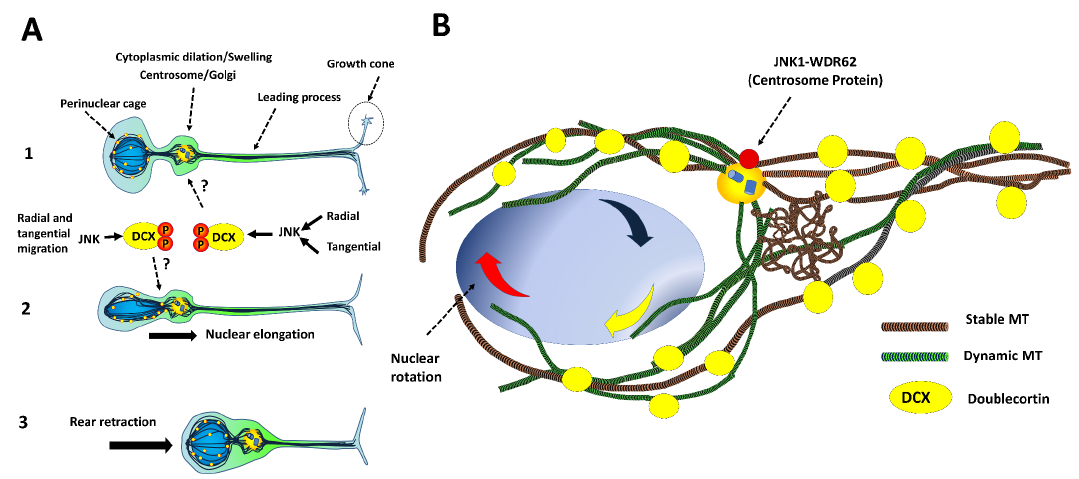
Figure 5. JNK1 regulates the phases of neuronal migration. ( A ) (1) Initially, the leading process is extended; (2) Later, the nucleus is pulled forward by the reorganization of microtubules that round the perinuclear cage; (3) Finally, rear retraction occurs. ( B ) Magnification of the perinuclear cage formed by MT. MTs (red and brown) are located around the nucleus (blue). The Centrosome / Golgi apparatus irradiates MTs toward the nucleus. Several targets of JNK1 are localized in the perinuclear cage (DCX,